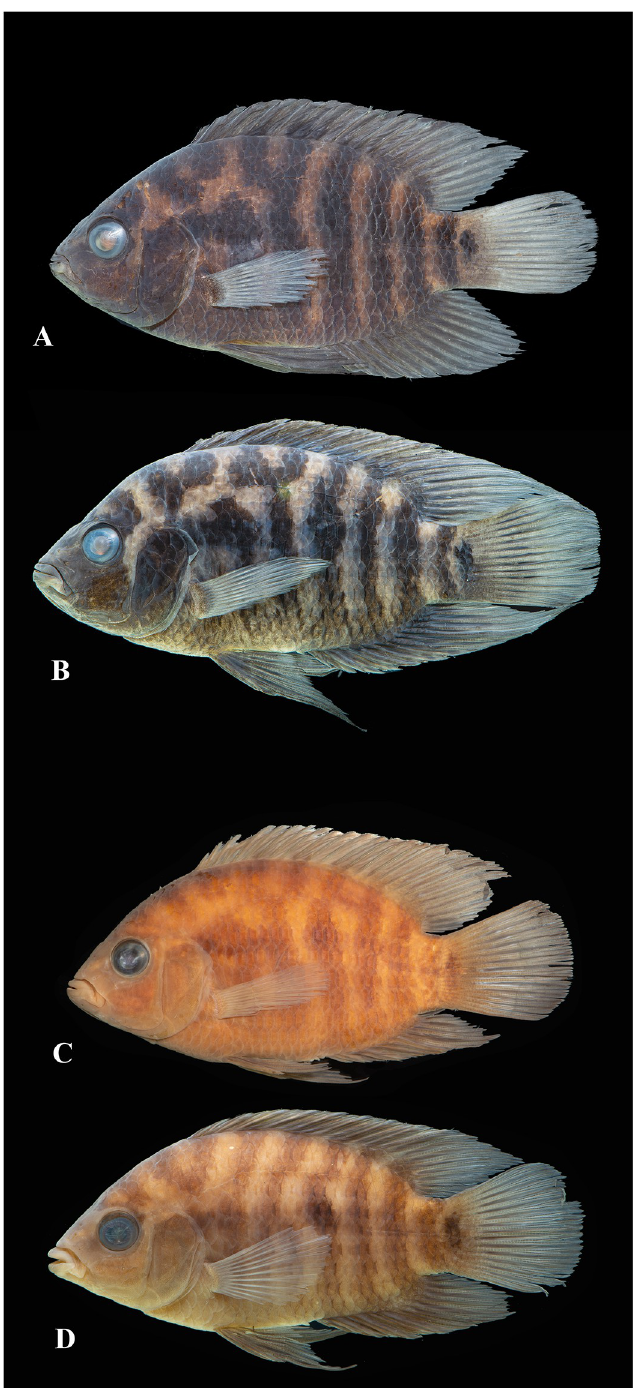
Fig 24. Australoheros ipatinguensis. A . young male, 54.5 mm SL; MCP 36657; Brazil: Rio de Janeiro: S ã o Francisco de Itabapoana: Rio Guaxindiba on Fazenda Santa Cruz, near Maniva. B . Adult male, 83.3 mm SL; MNRJ 47307; Brazil: Rio de Janeiro: Itaperuna: bridge over the Co´rrego S ã o Domingos, on road toward Fazenda S ã o Domingos. C . Adult female, MZUSP 16178, 77.3 mm SL; Brazil: Rio de Janeiro: Rio Paraı´ba do Sul at S ã o Jo ã o da Barra. D. Adult male, 60.6 mm SL; UFBA 4995; Espı´rito Santo: Pedro Cana´rio: Rio da Samambaia, on BR.